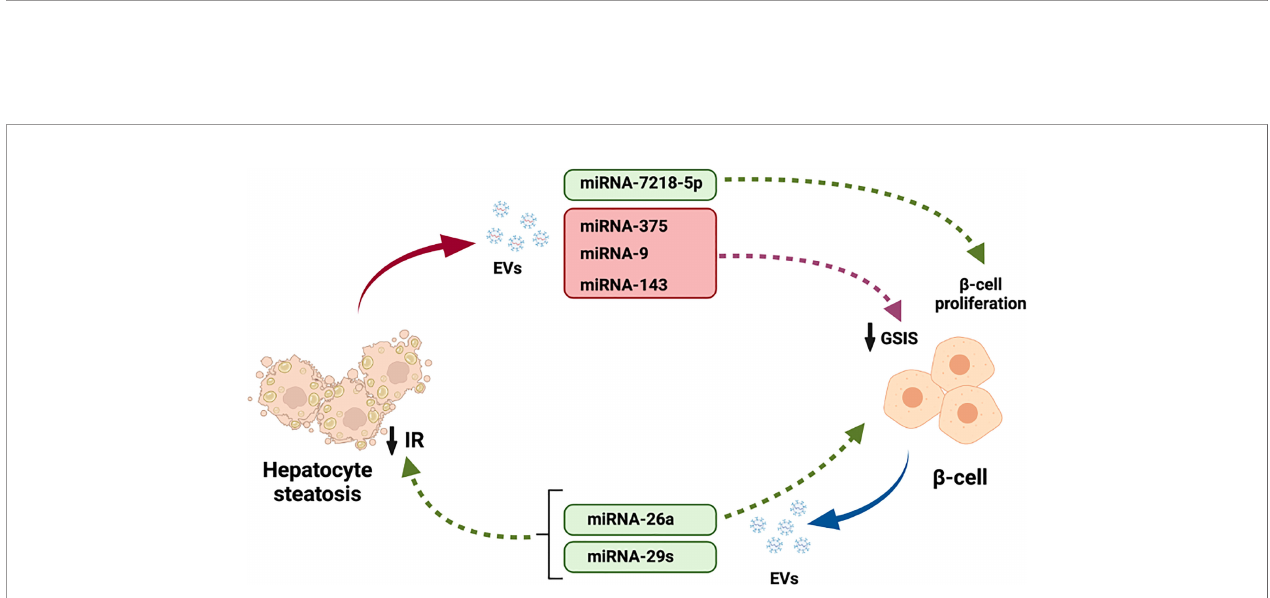
FIGURE 3 | Participation of EVs cargo in the crosstalk between hepatocytes and pancreatic b -cells. Steatotic hepatocytes release EVs with miRNAs-375, 9 and 143 that reduced b -cell GSIS. Moreover, miRNA-7218-5p released by fatty liver promotes b -cell proliferation. In addition, miRNAs-26a and 29s released by b -cell EVs regulate liver